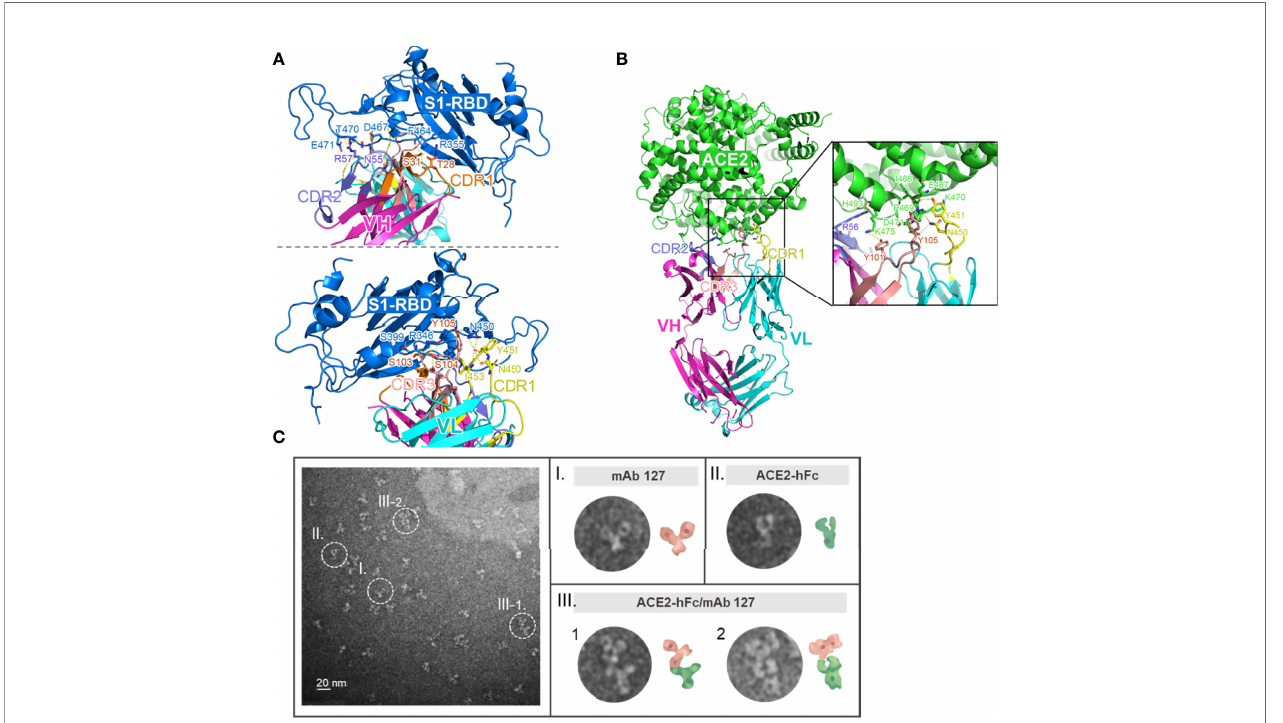
FIGURE 6 | Footprints of mAb 127 binding to S1-RBD and ACE2. (A) A modeled structure of mAb 127 Fab/S1-RBD complex. mAb 127 Fab is generated by AlphaFold2 and the interaction is predicted by antigen-antibody docking. The interaction of the variable region of heavy chain (VH) (upper panel) and the light chain (VL) (lower panel) of mAb 127 with S1-RBD are visualized by Pymol. VH, magenta; VL, cyan; S1-RBD, blue. (B) A modeled structure of mAb 127 Fab/ACE complex. VH, magenta; VL, cyan; ACE2, green. (C) Negative-stain electron microscopy of samples containing mAb 127 (I) and ACE2-hFc (II). Representative two-dimensional class averages of ACE2-hFc bound by mAb 127